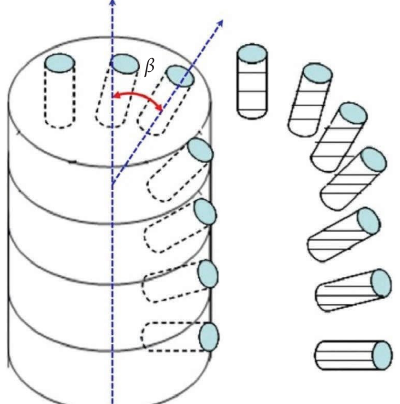
Figure 1: Shale specimens of 7 diferent coring